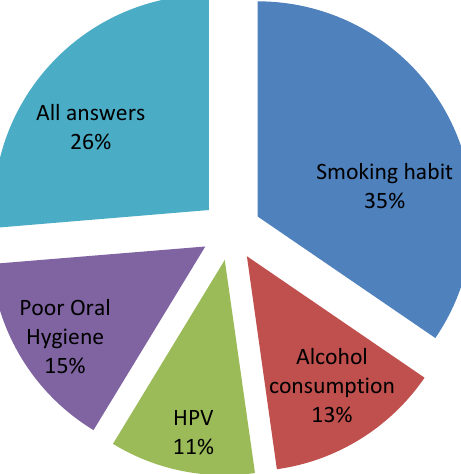
Figure 3. Pie chart of answers related to knowledge of OSCC risk factors.